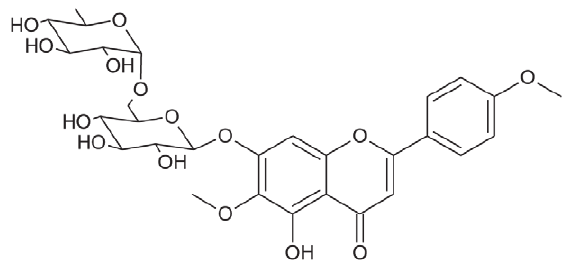
Fig. 1 - Structure of